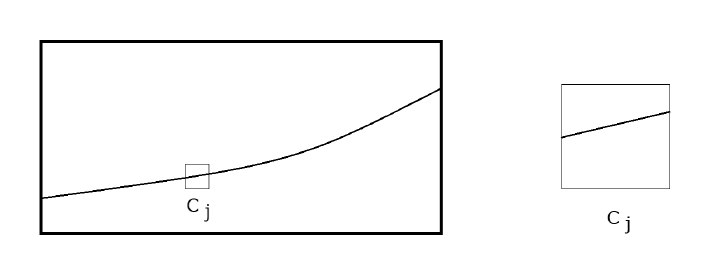
Figure 4. Second step of the reiterating